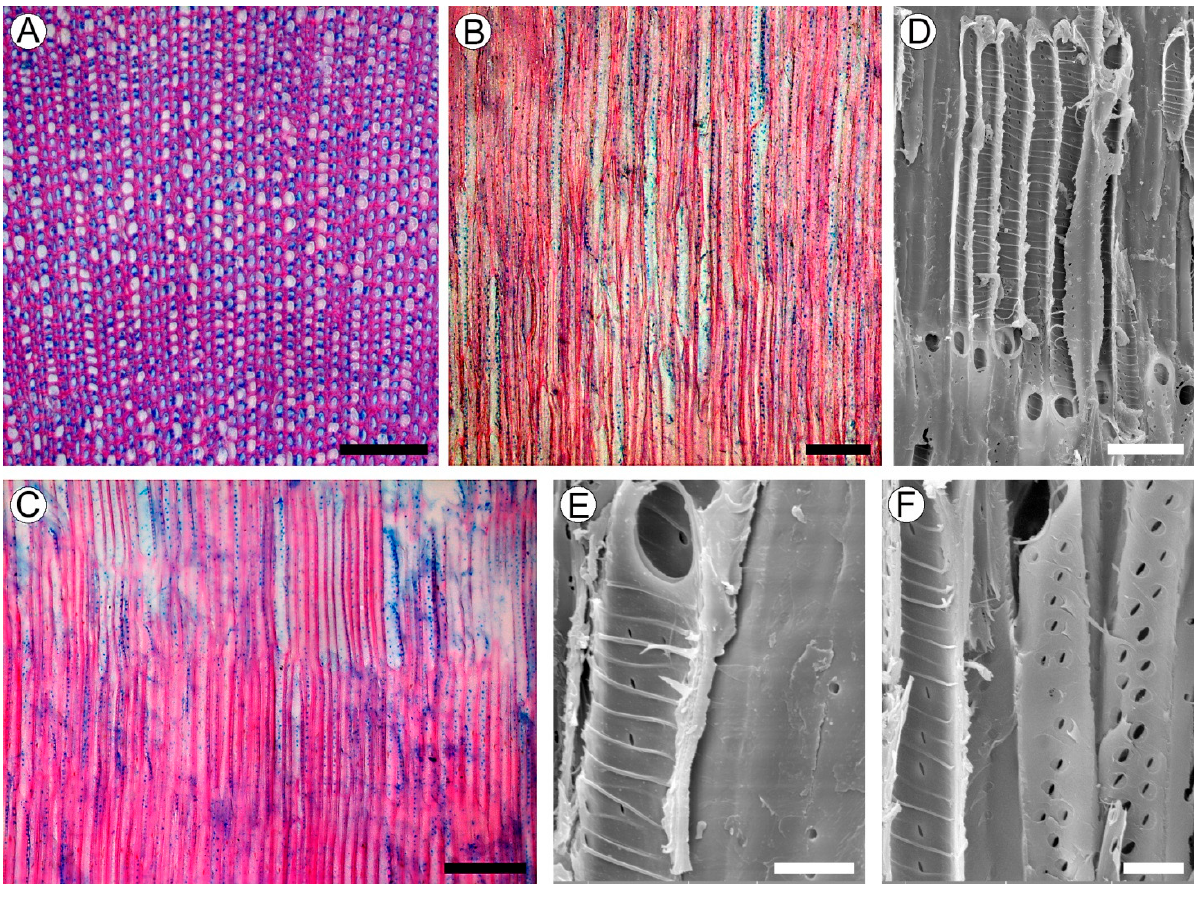
Figure 4. Wood structure of Aragoa corrugatifolia . ( A ) TS of wood (LM), growth rings absent, very narrow vessels, libriform fibers with living protoplasts; axial parenchyma and rays absent; ( B ) TLS of wood (LM), very narrow vessels, lack of rays; ( C ) RLS of wood (LM), imperforate elements with numerous pits in radial walls, lack of rays; ( D ) vessel elements on RLS (SEM), simple perforation plates, helical thickenings on vessel walls; ( E ) vessel element and fibriform fiber on RLS (SEM), simple perforation plates, helical thickenings on vessel walls, pits on the fiber wall (right); ( F ) vessel elements on RLS (SEM), helical thickenings on vessel walls; minute intervessel pits. Scale bars: 100 µm for ( A – C ), 10 µm for ( D – F ).